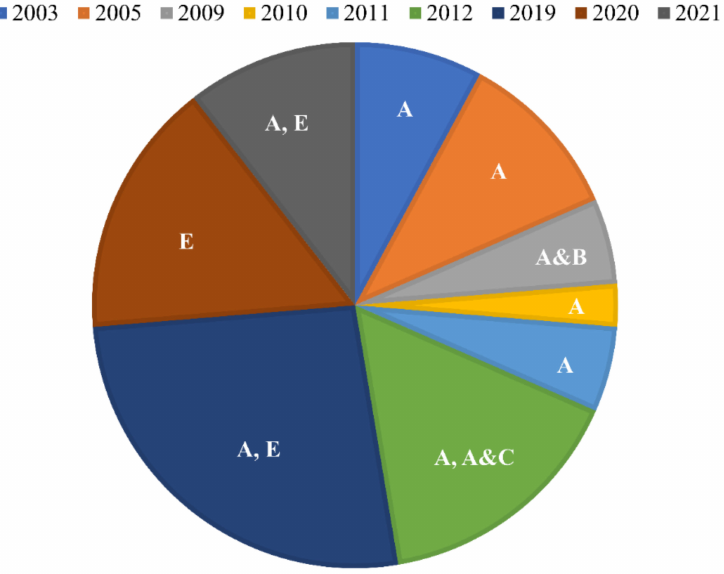
Figure 5. Proportions of Plasmodium DHFR structures released by the PDB by year. The different groups responsible for solving the deposited structures are identified by the letters A to E. The use of the comma (,) and ampersand (&) signifies independent and collaborated work among groups in solving the structures